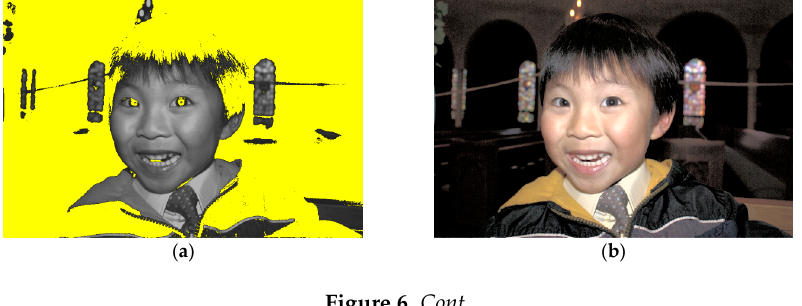
Figure 6 . Cont . Figure 6.